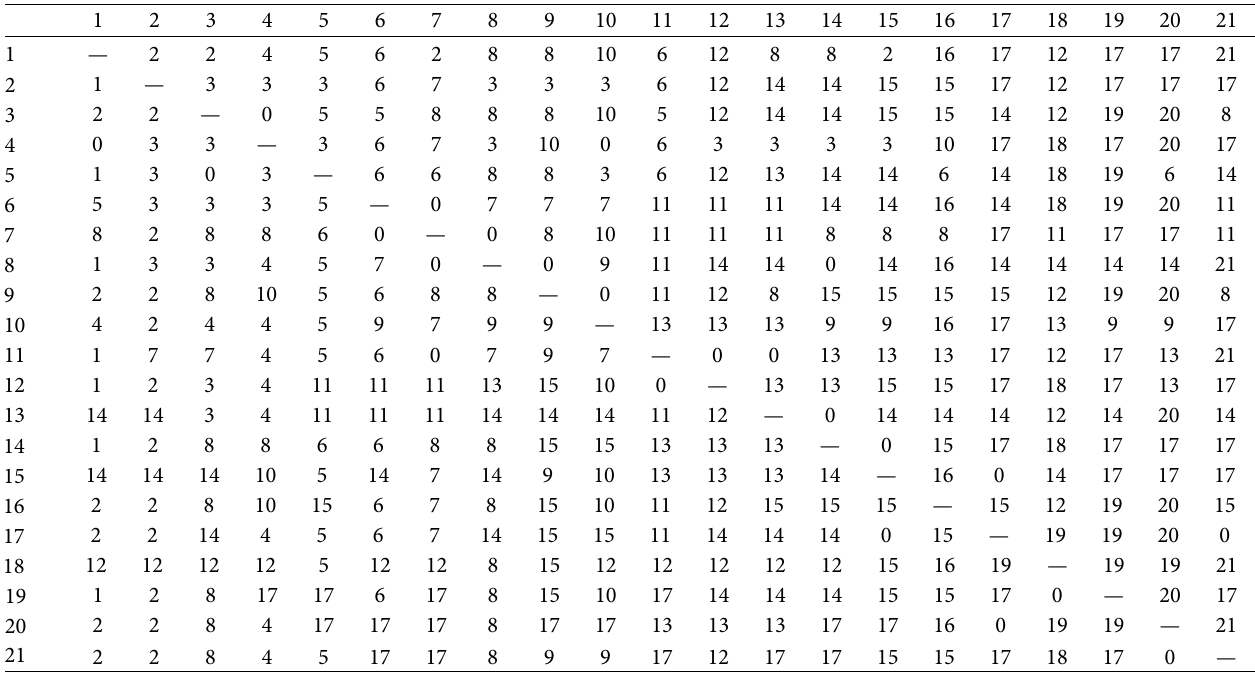
Table 6: Cars’ reclassification strategies.